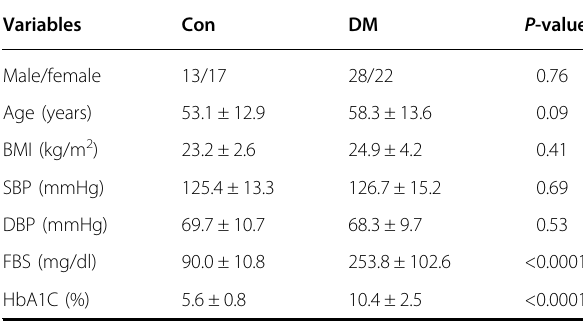
Table 1 The baseline characteristics of the subjects.